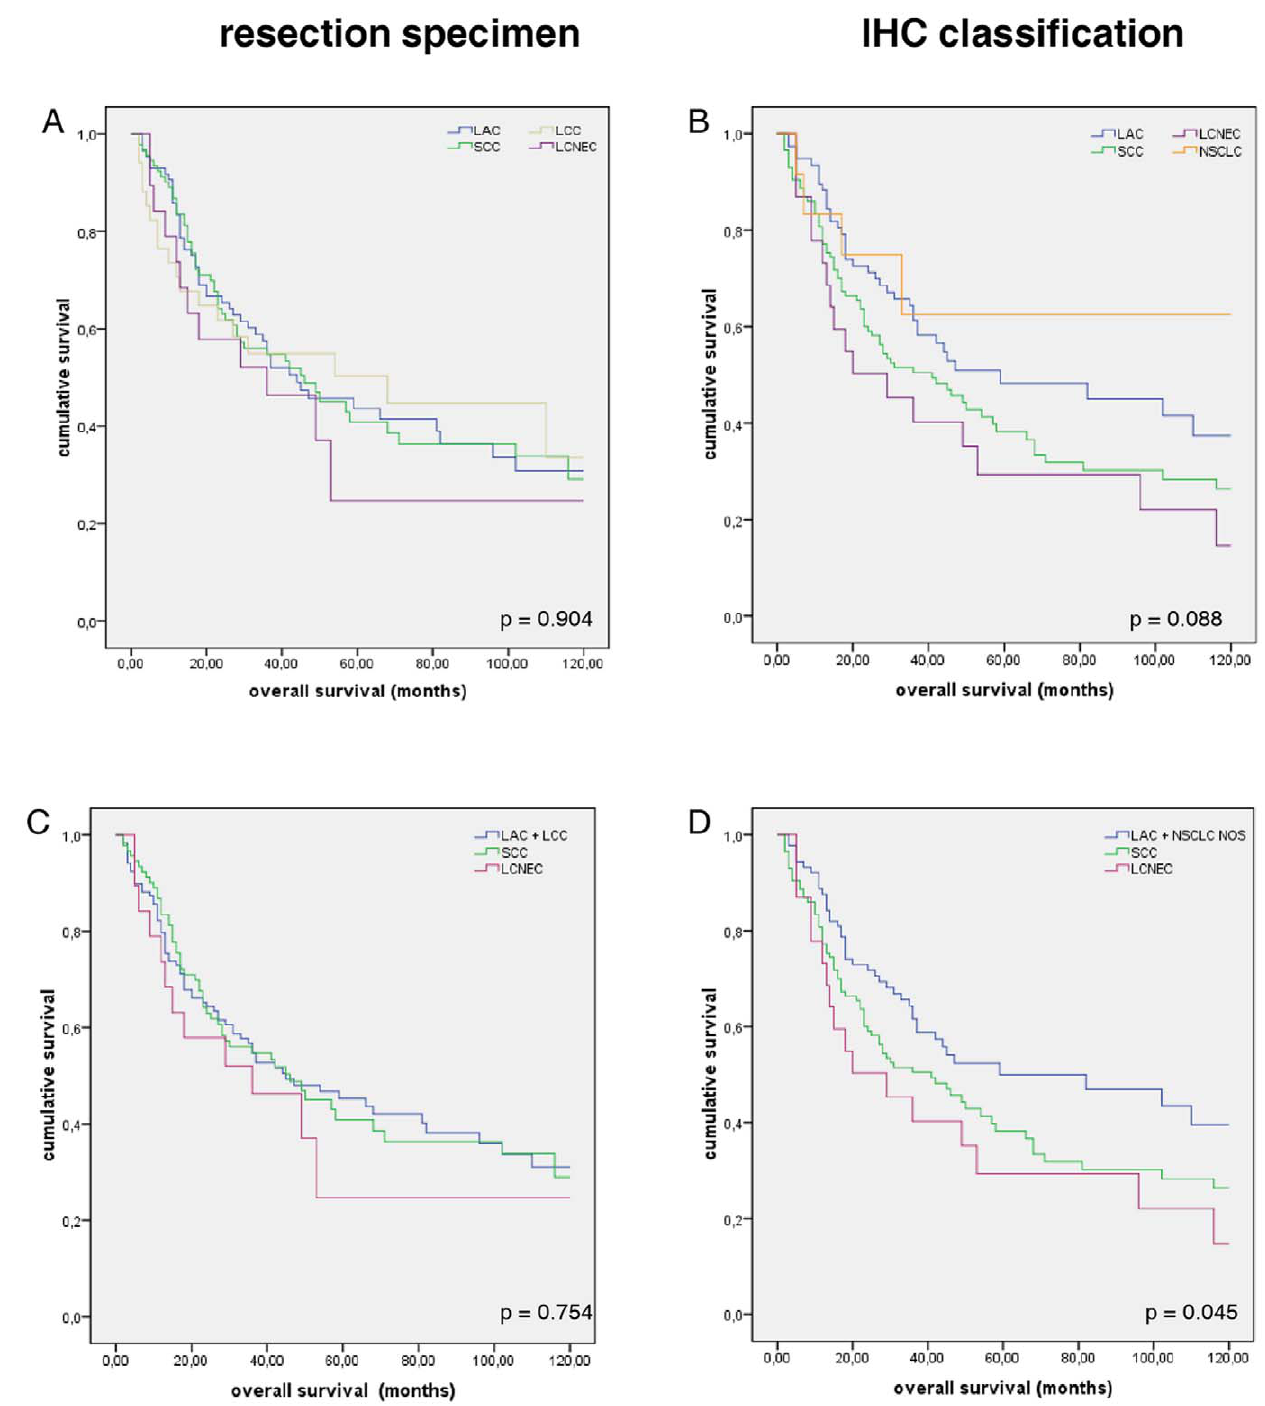
Figure 3. Kaplan-Meier survival curves for histological NSCLC subtypes. NSCLC subtypes were diagnosed by H&E on resection specimens (A) and by combined IHC classification algorithm (B). Additional IHC classification separates distinct histological entities suggesting different biological behavior. Grouping the different entities according to therapeutic consequences (C and D), no differences in survival are evident by conventional H&E classification of resection specimens (C), whereas combined IHC classification significantly separates the different survival curves (p=0.045; D).